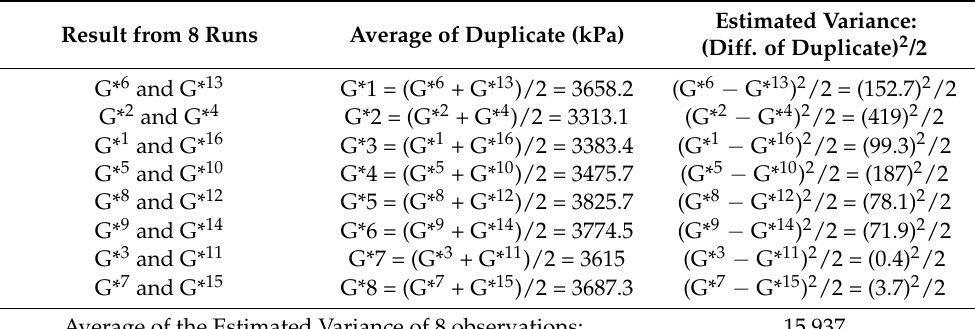
Table 3. Estimating the variance for each set of conditions for G* at frequency of 10 rad/s and temperature of 60 ◦ C for